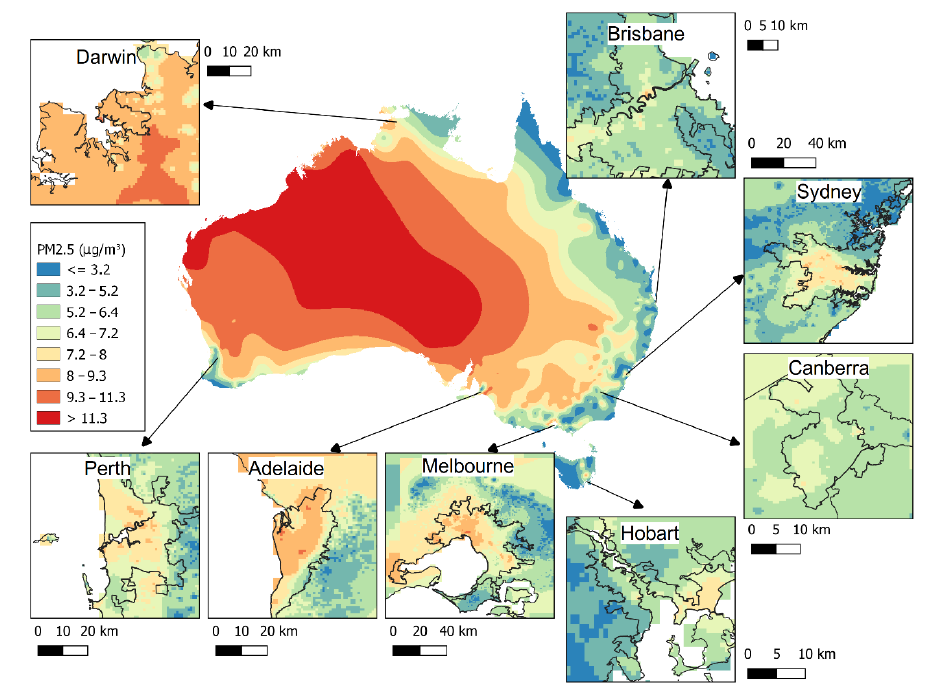
Figure 2. Map of Australia showing modelled estimates of annual average PM 2.5 (µg/m 3 ) concentrations in 2015.